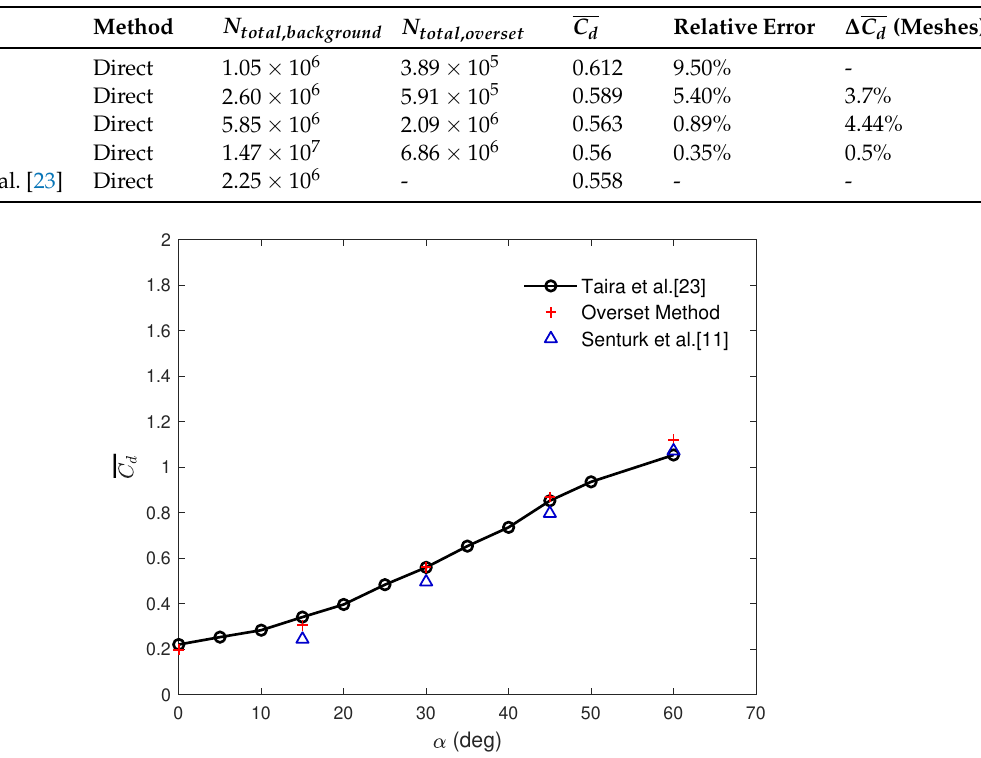
Table 2. Grid sensitivity investigation.